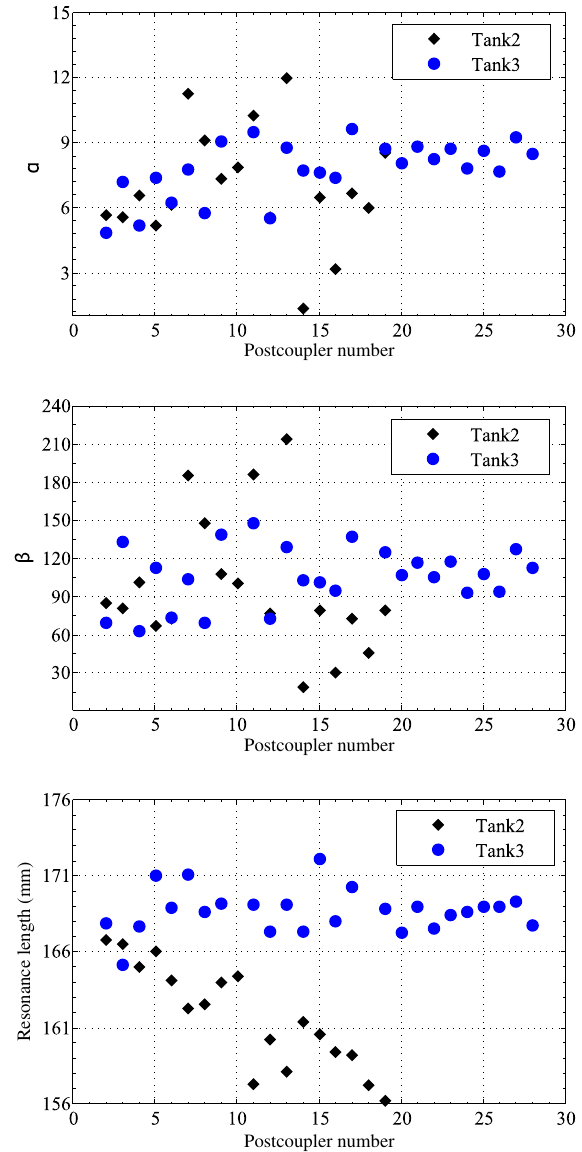
FIG. 9. Parameters α n , β n , and the resonance length l r n for all post-couplers of Tank 2 (diamonds) and Tank 3 (dots). Note that the values are measured separately on either side (even- or odd- numbered post-couplers) and that all parameters depend on the settings of the next-neighbor